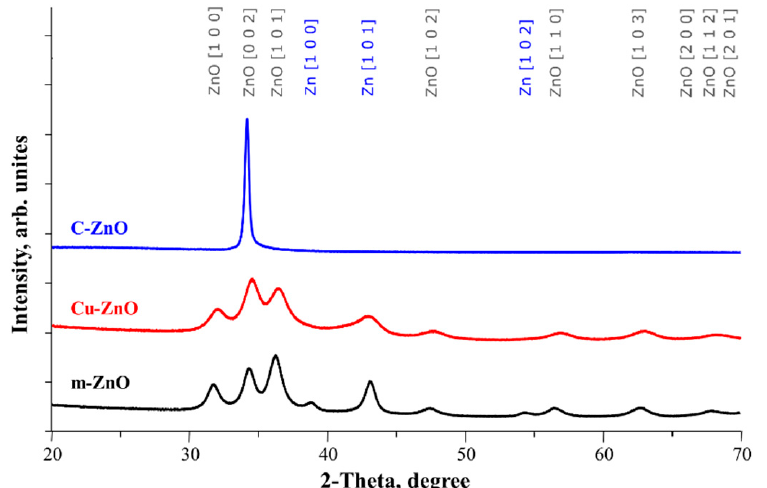
Figure 1. XRD patterns of ZnO films without and with extrinsic dopants: m-ZnO marks ZnO film without extrinsic dopants; Cu-ZnO marks ZnO film doped by copper; C-ZnO film marks ZnO doped by carbon. XRD data recorded using theta–theta modification, Cu K α radiation, Lynx Eye linear position sensitive detector and 0.01° measurement step size.